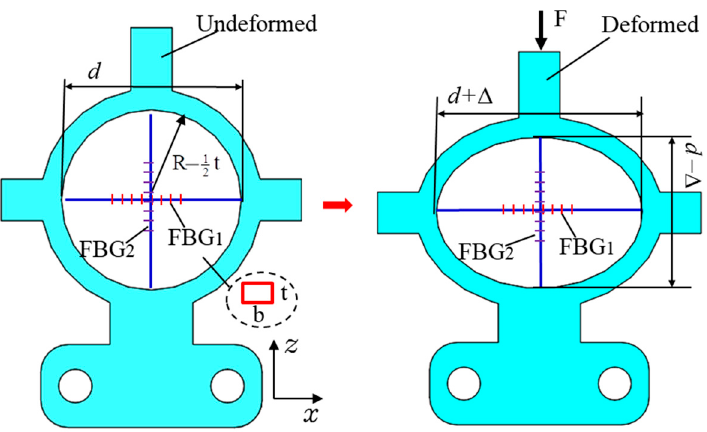
Figure 2. Stress diagram of elastic ring structure.